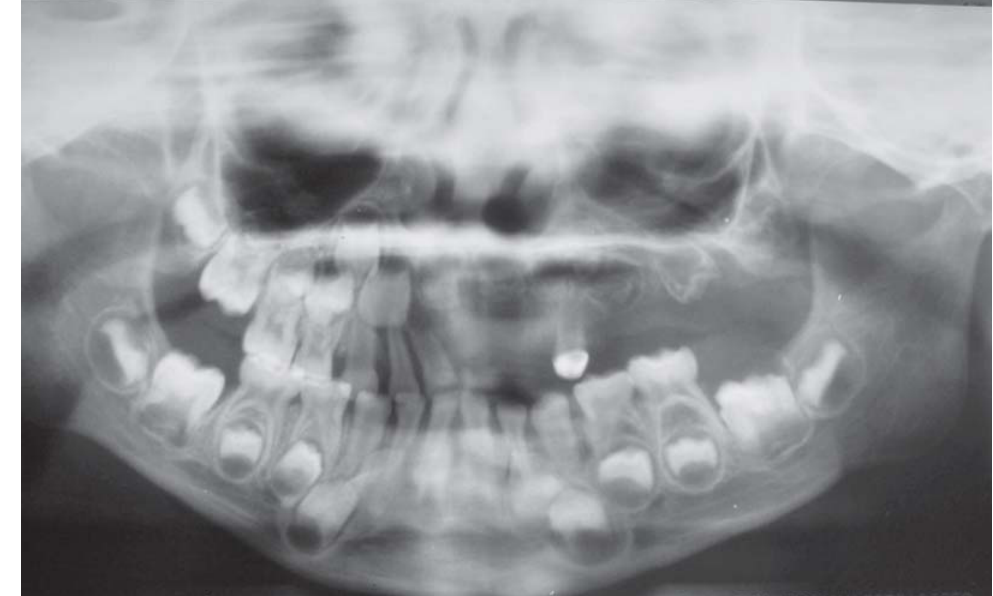
FIGURE 7- Panoramic radiograph showing the teeth with “ghostlike” appearance in maxillary left quadrant and the right permanent central